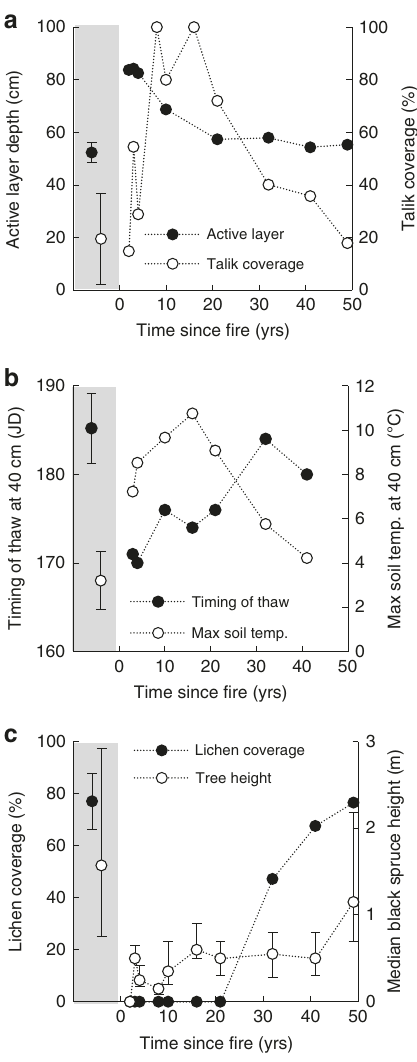
Fig. 3 Trajectories of soil thermal regime and vegetation reestablishment on peat plateaus following wild fi re. a Active layer depth (cm), and talik coverage (%). Taliks are continuously thawed soil layers between the permafrost and the seasonally frozen soil. No active layer estimates were possible for sites burned 7 and 16 years ago due to complete talik coverage. b Timing of thaw at 40 cm depth (Julian Date, JD), as indicated by timing of the fi rst exceedance of 0.5 °C soil temperature, and the maximum annual soil temperature (°C) at 40 cm. Soil temperature loggers malfunctions at sites burned 7 and 49 years ago, and is missing. c Trajectories of vegetation reestablishment, including ground cover of lichens (%), and median height of black spruce trees (m), where error bars indicate interquartile range. In each panel, the average of 6 unburned sites is shown on the left with gray background, where error bars indicate ±1 standard